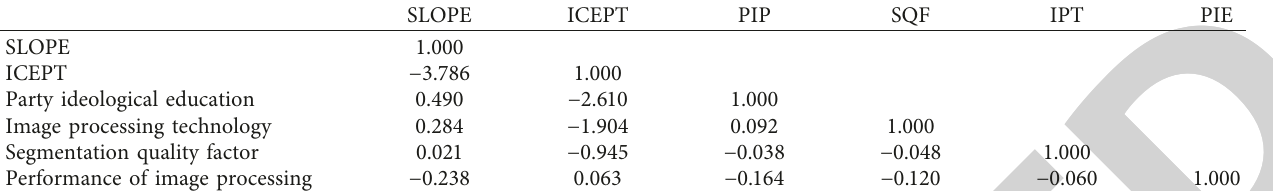
Table 5: Implied (for all variables) correlations.